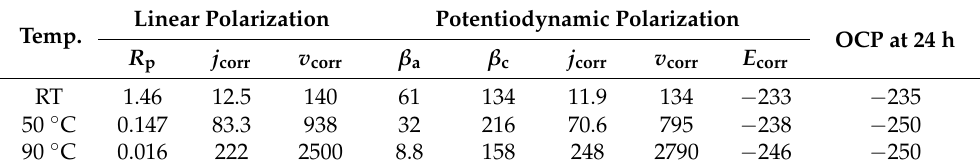
Table 2. Electrochemical parameters ( E corr and OCP (mV), β x (mV), R p (k Ω · cm 2 ), j corr ( µ A/cm 2 ) and v corr ( µ m/year)) extracted from OCP, linear polarization and potentiodynamic polarization curves for the grade 316L stainless steel exposed to the 10% H 2 SO 4 solution with 5000 mg/L NaCl at various temperatures. Figure 5. The cross-section reduction of the grade 316L after 28 days of exposure in the 10% H 2 SO 4 solution containing 5000 mg/L NaCl at 65 °C and at room temperature: ( a ) left edge of a 0.5 mm thick steel sheet; ( b ) middle section of a 0.5 mm thick steel sheet; ( c ) right edge of a 0.5 mm thick steel sheet. Temp.